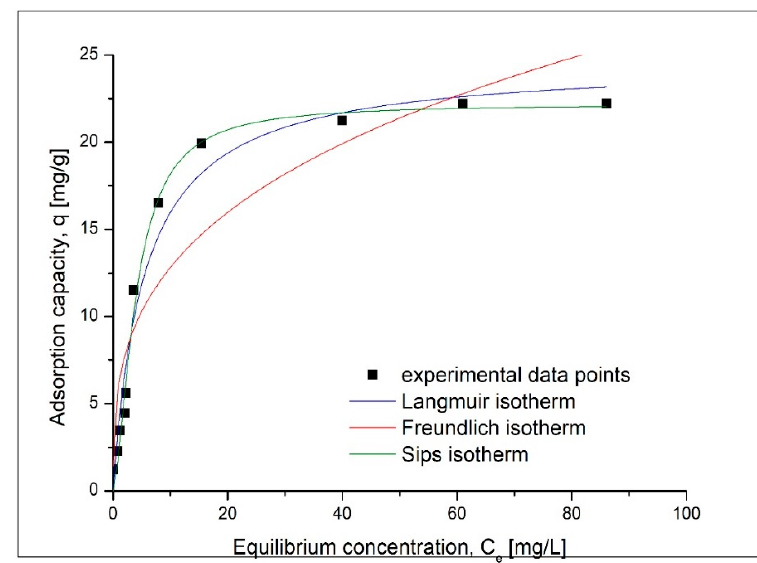
Figure 10. Sorption isotherms models.